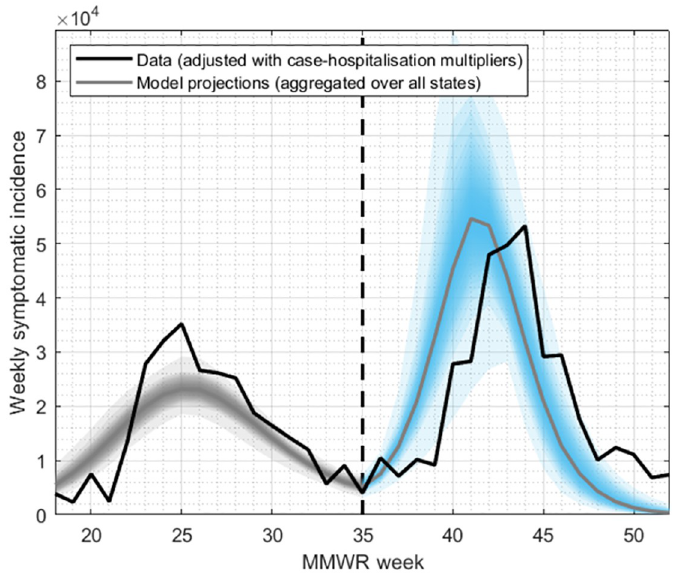
Fig 2. Illustration of the modelling approach, and of model projections, in the example of California. For each state shown in Fig 1, we calibrated the model to the epidemic data from the spring wave (black line, to the left of the vertical dashed line, with aggregated model projections shown in grey shaded area). Using this calibrated model, we projected simulations forward into the fall, taking account of the effect of school openings and environmental forcing (blue shaded area). Although the model projection for epidemic peak timing varied in accuracy across states, our subsequent analysis concentrates on cumulative burden (area under the curve). See S2 Fig for results for other states.